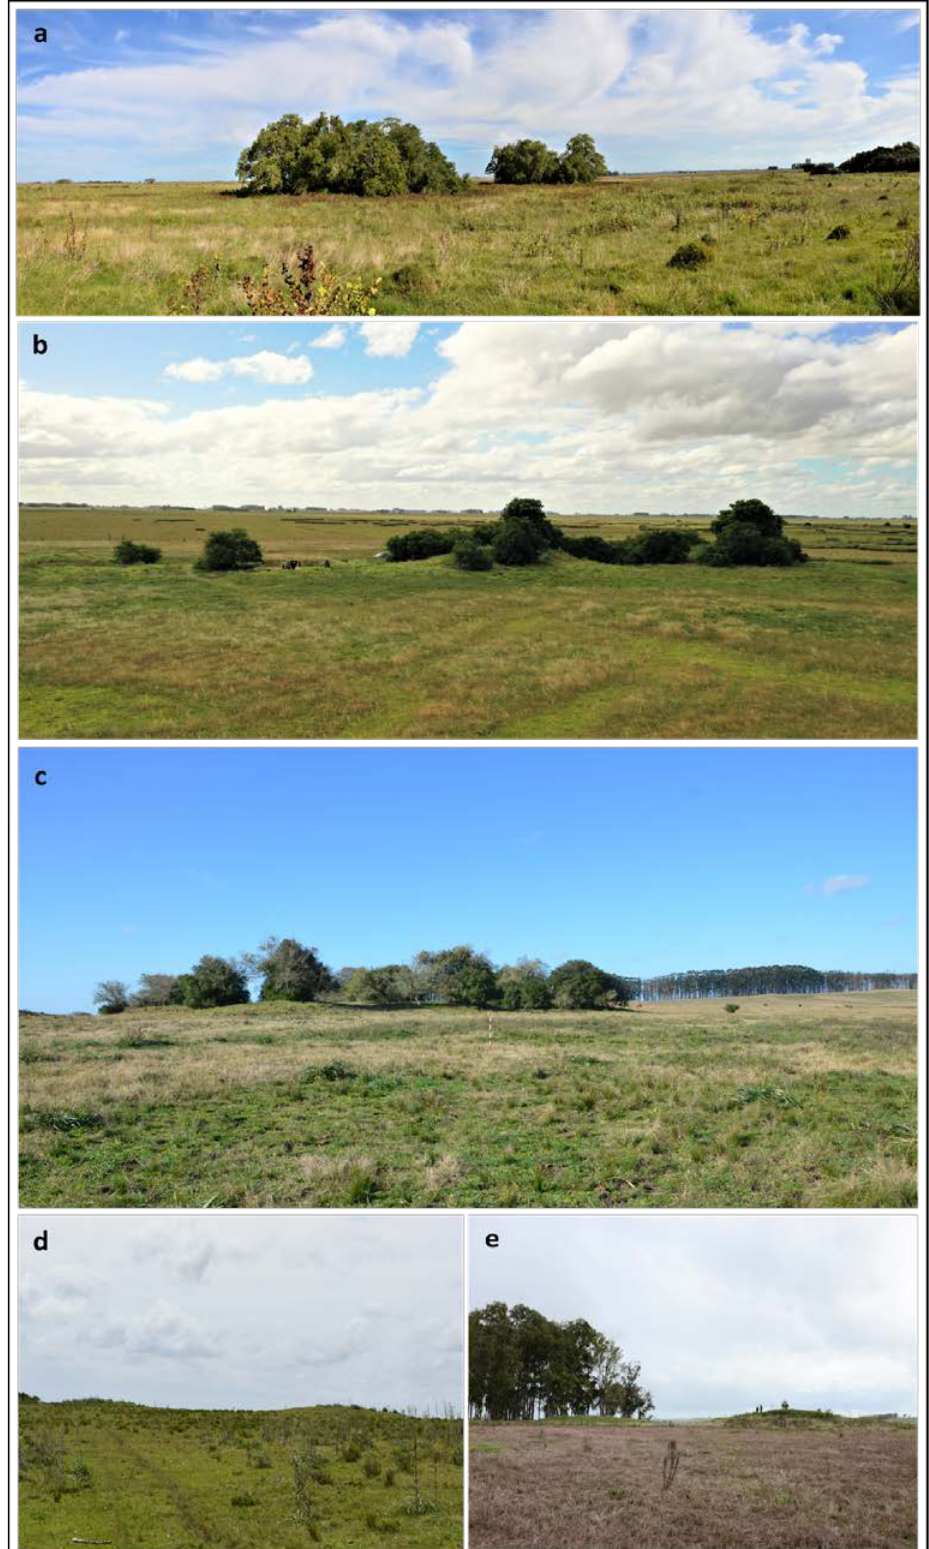
Figure 3. Mound sites analyzed: ( a ) Garcia Ricci from the E-NE; ( b ) Talitas from the E; ( c ) Los Ajos from SW. In the foreground, the circular grouping of mounds of the middle plain and, in the background, the location on a hill of mounds; ( d ) Los Indios A, details of two mounds with earth embankment from de E-NE; ( e ) Los Indios B, details of two mounds on the edge of the hill from de